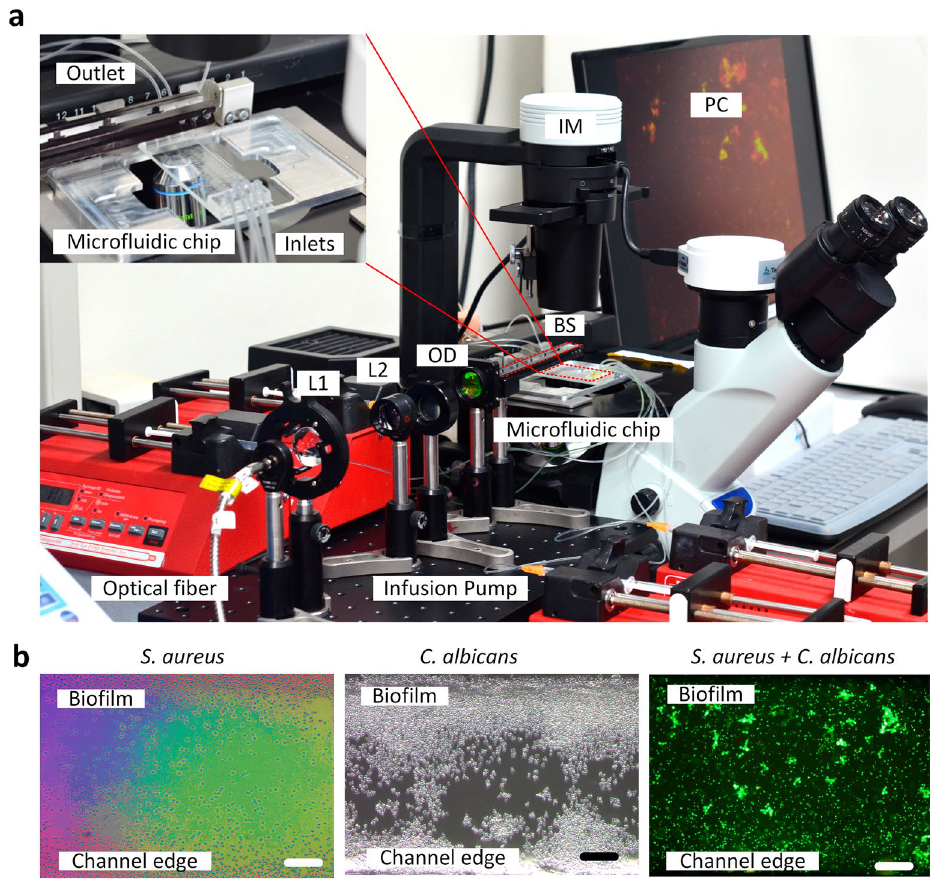
Figure 8. Experimental setup of the opto-microfluidic platform for biofilm culture and treatment: ( a ) experimental setup and ( b ) S. aureus biofilm (left), C. albicans biofilm (middle), and dual-species biofilm ( S. aureus + C. albicans ; right) ( IM inverted microscope, L1–L2 lenses, OD optical diffuser, BS beam splitter, PC personal computer; scale bar = 25